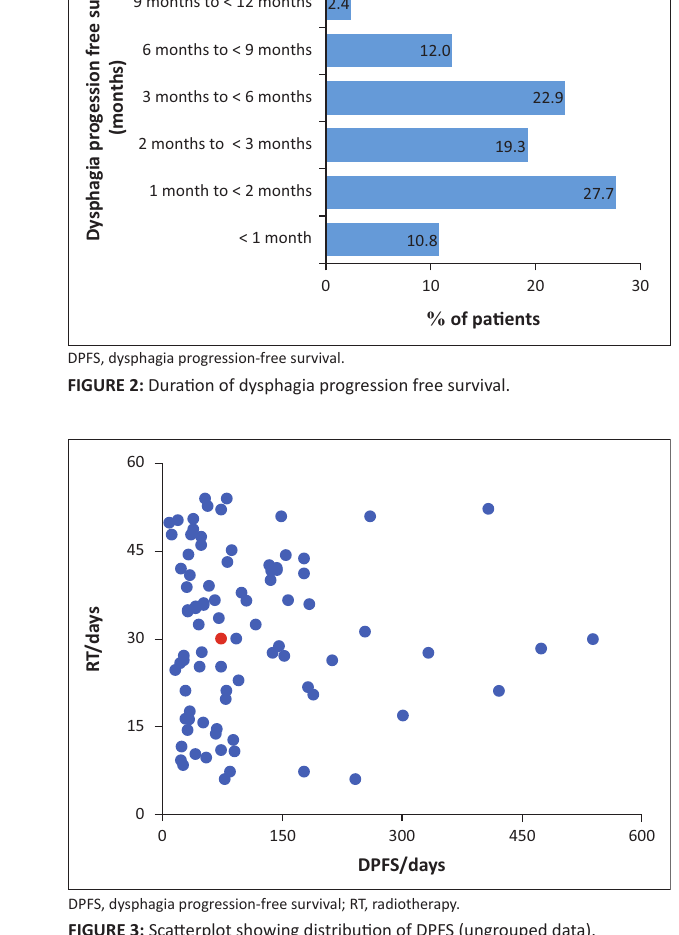
FIGURE 1: Bar chart showing Dysphagia score at various time intervals.